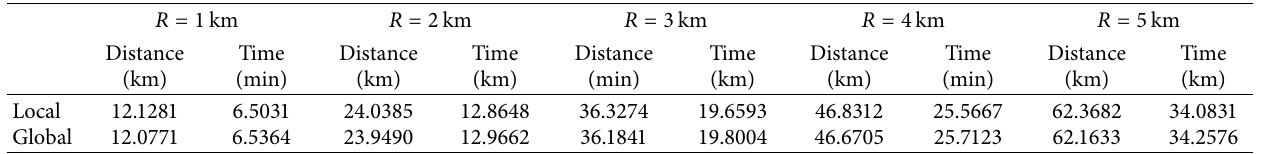
Figure 11: The results of two algorithms when R � 5km: (a) total task time of two algorithms; (b) total task distance of two algorithms. Maximum optimization rate: 17.16%; maximum optimization rate: 5.52%. Table 8: The average of the results of the two